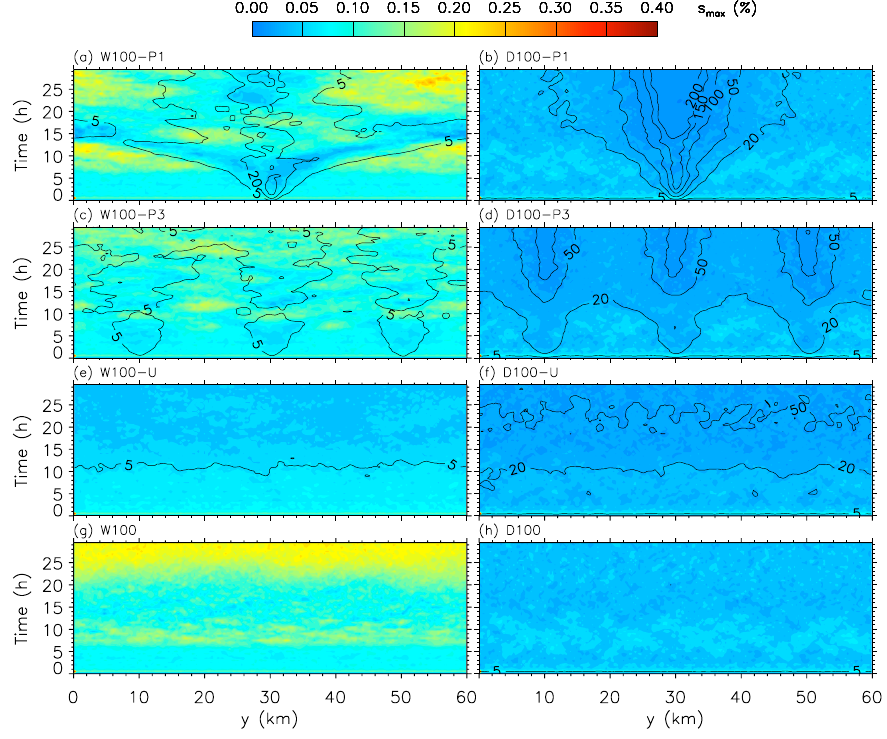
Fig. 4. Same as Fig. 3 but for the W100 and D100 cases.